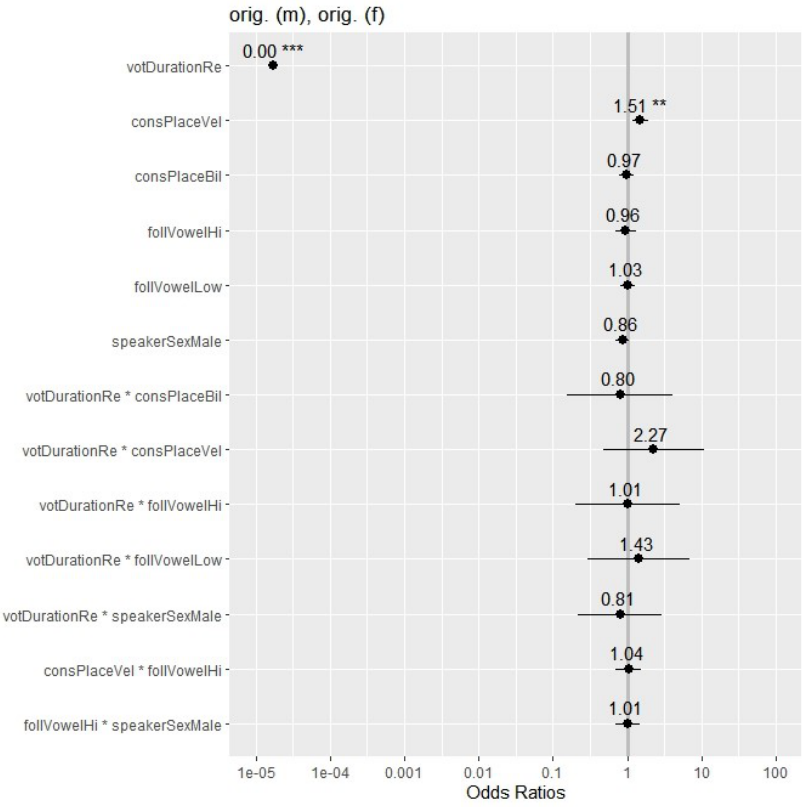
Figure 3. Odds ratios (ORs) of ‘voiced’ responses across the fixed effects and interactions in the glmer model for the original male and female voice tokens in the − 20 ms to +20 ms VOT range. Significance is shown with asterisks (‘***’: p < 0.001; ‘**’: p < 0.01.). Confidence intervals (CIs: 95%) are marked with